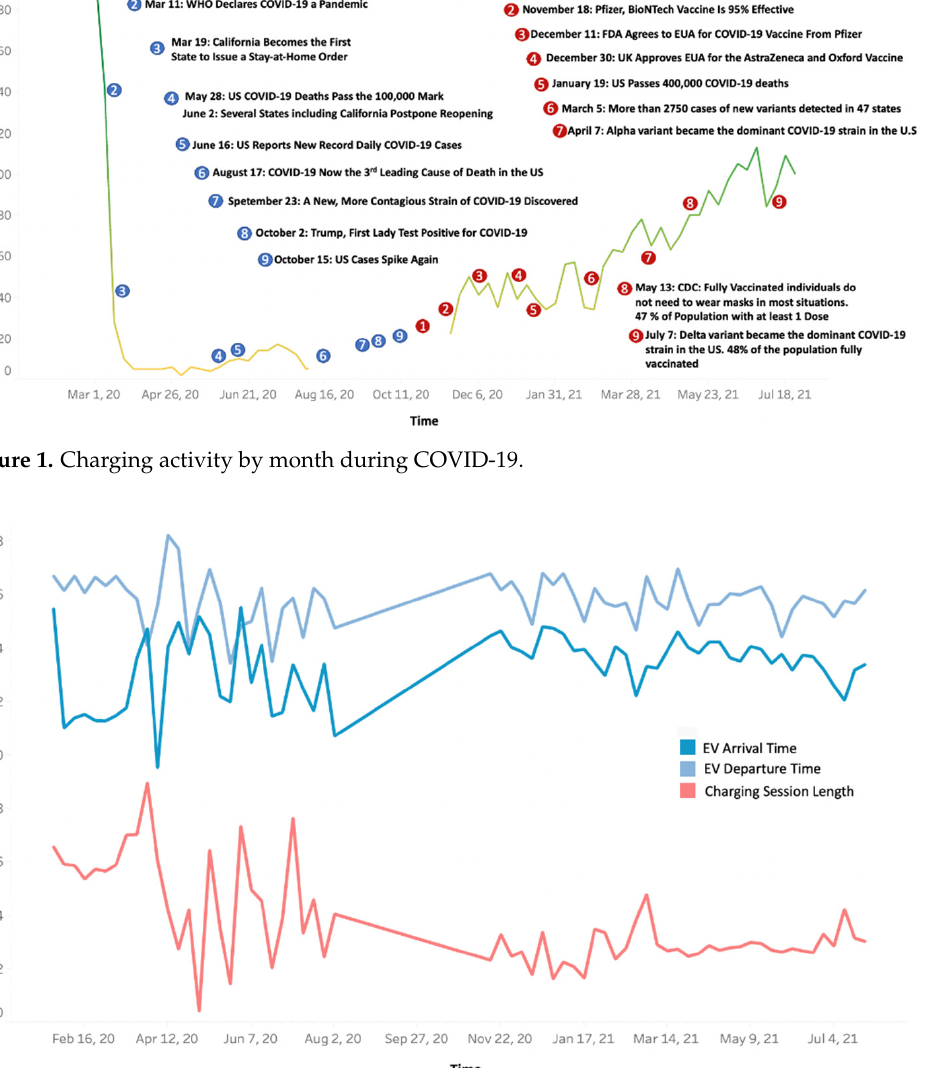
Figure 2. Charging behavior trends during COVID-19.